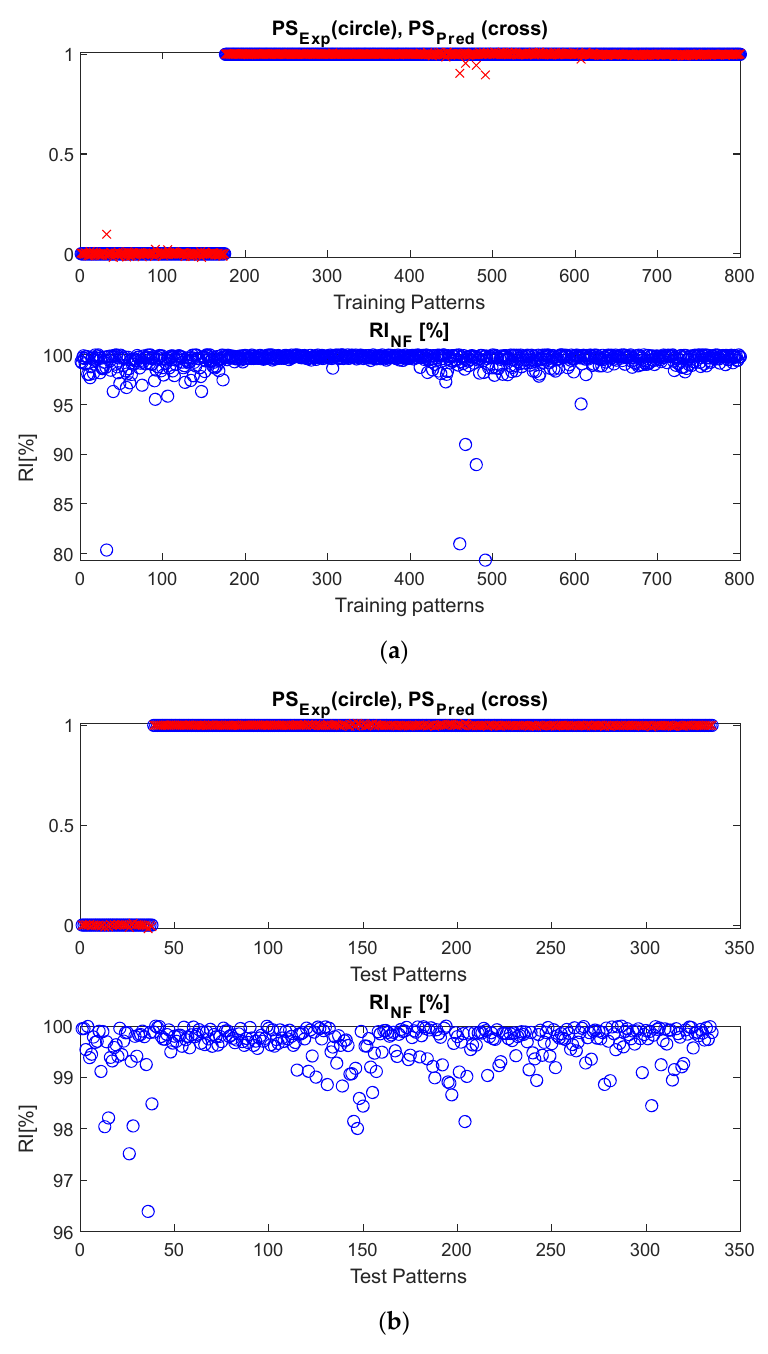
Figure 8. Results obtained by the NF inference system, fed with DWT-based features, in the case of the optimal range of influence. Both ( a ) training and ( b ) test datasets are shown.